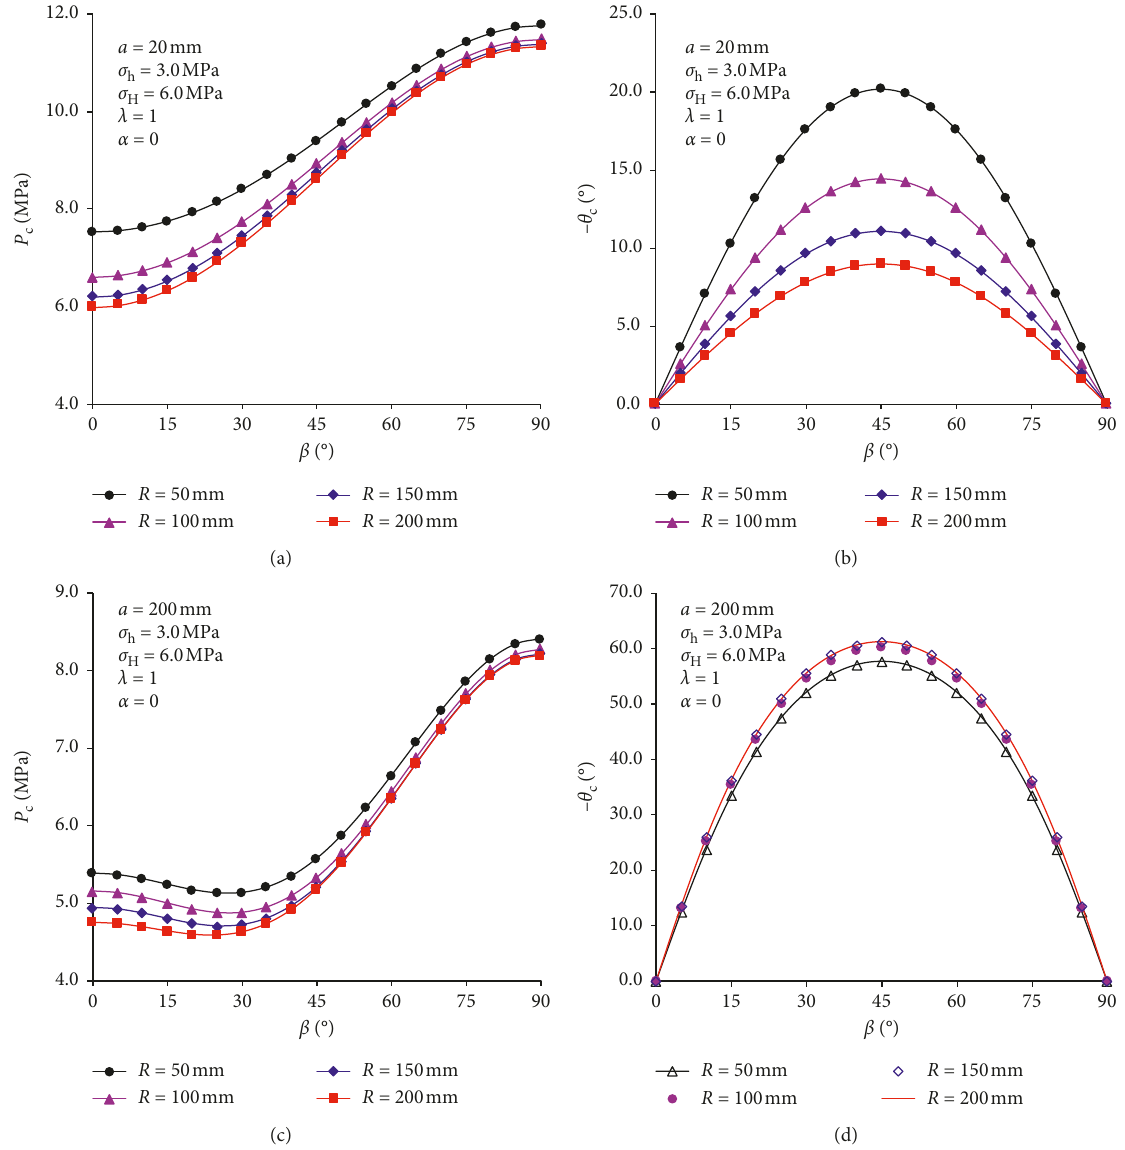
Figure 11: Effect of the borehole radius on the critical water pressure and critical initiation